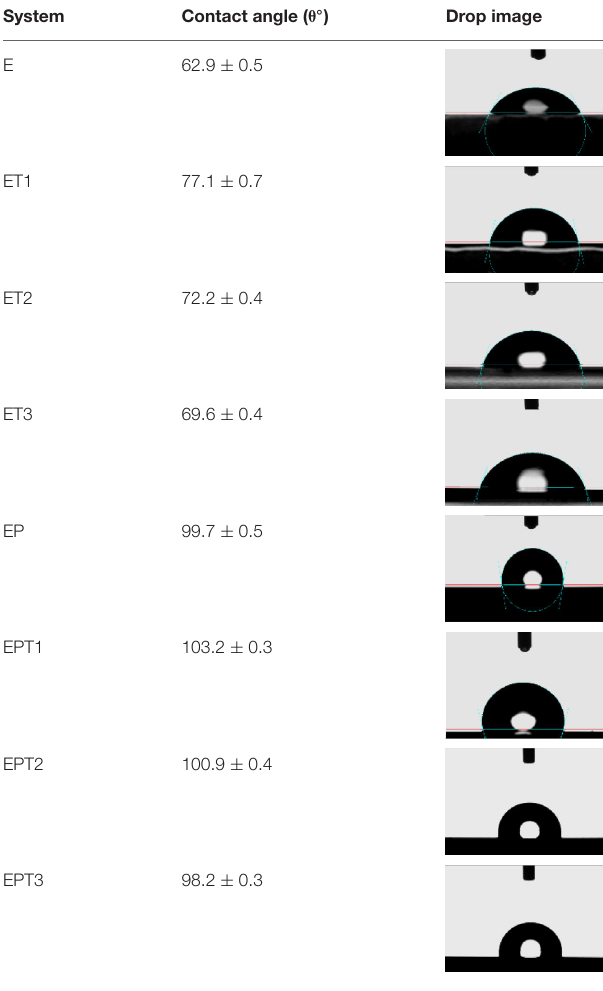
TABLE 2 | The water contact angle values of all developed coating systems.